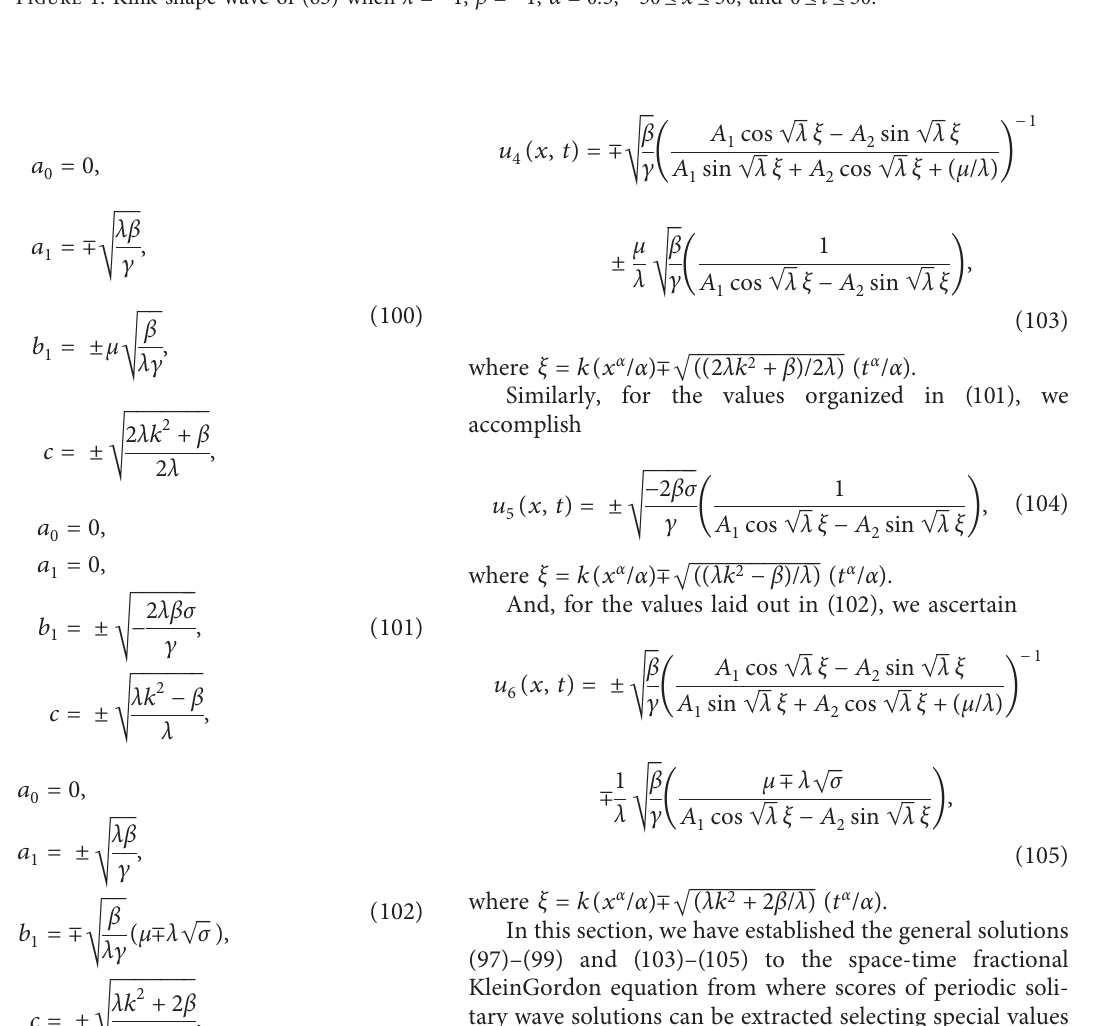
Figure 1: Kink-shape wave of (63) when λ � − 1, β � − 1, α � 0 . 5, − 50 ≤ x ≤ 50, and 0 ≤ t ≤